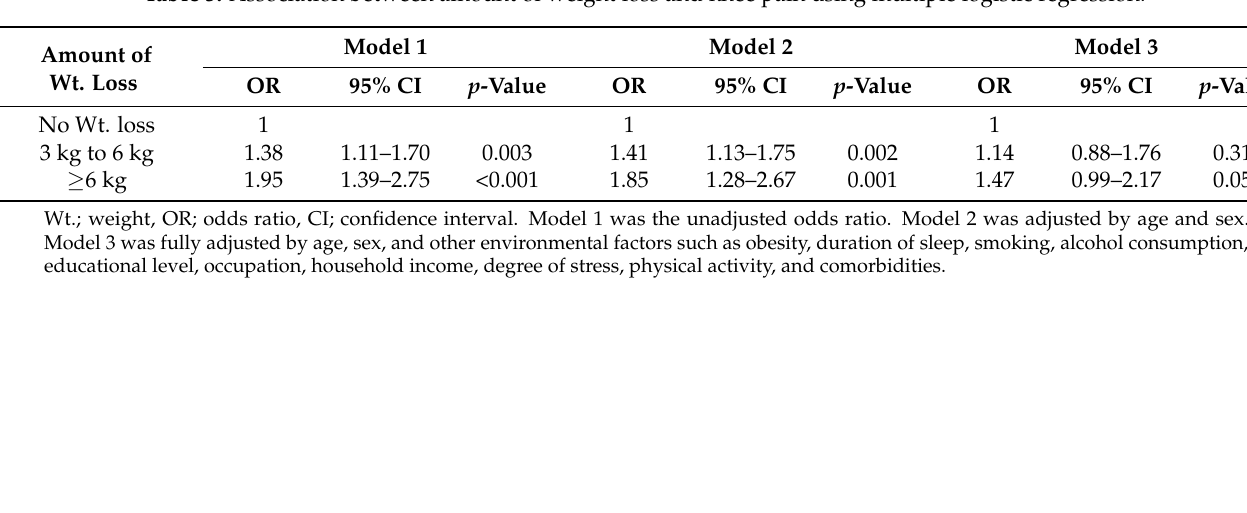
Table 3. Association between amount of weight loss and knee pain using multiple logistic